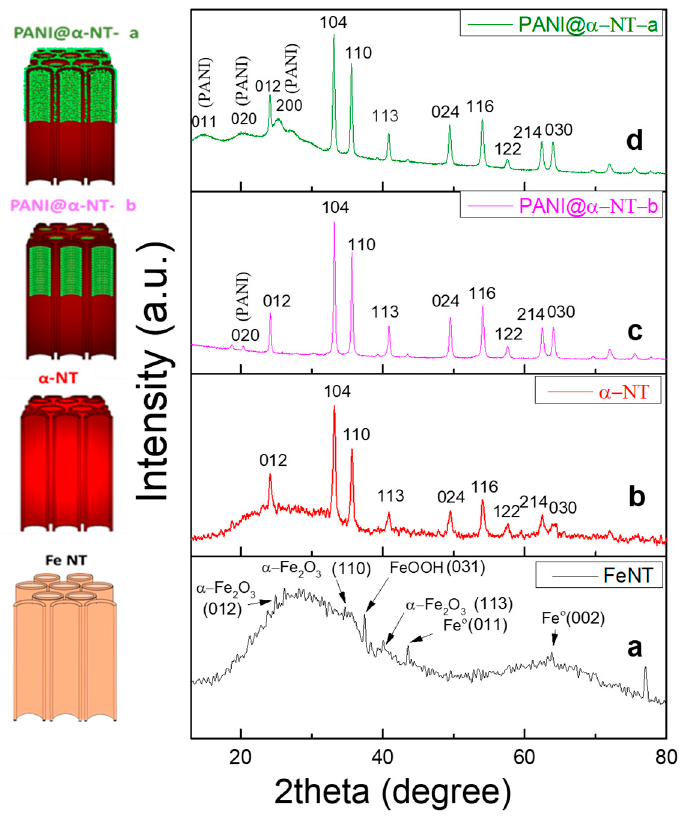
Figure 3. XRD analysis of ( a ) FeNT, ( b ) α -NT nanotubes, ( c ) PANI@ α -NT-b, and ( d ) PANI@ α -NT-a.